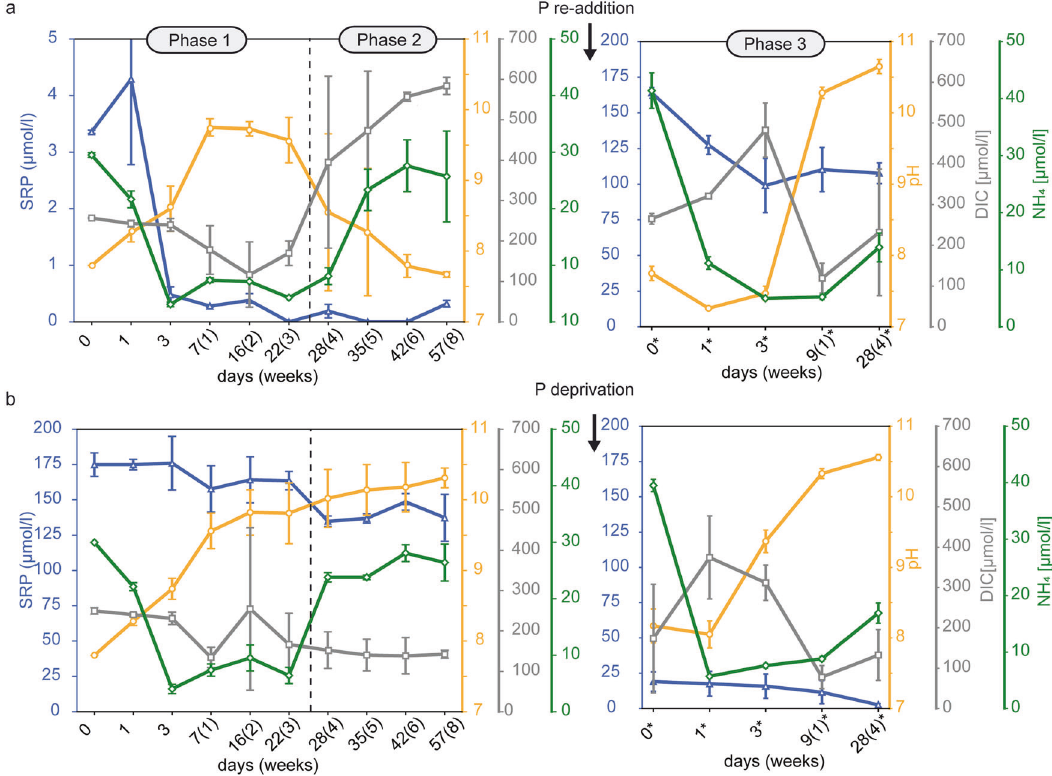
Fig. 1 Medium composition at different bio fi lm development phases during the 12 weeks experiment. Numbers marked by a star symbol in Phase 3 indicate days after P re-addition or P-deprivation at day 57. a The low P experiment is characterized by proliferation in Phase 1 (3 weeks), pausing proliferation in Phase 2 (5 weeks) and proliferation after P re-addition in Phase 3 (4 weeks), while the high P control experiment ( b ) is characterized by proliferation in all Phases (1 – 3). Error bars display standard deviation of